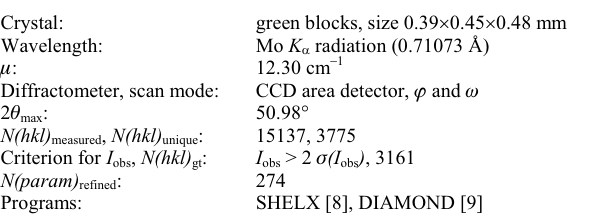
Table 1. Data collection and handling.